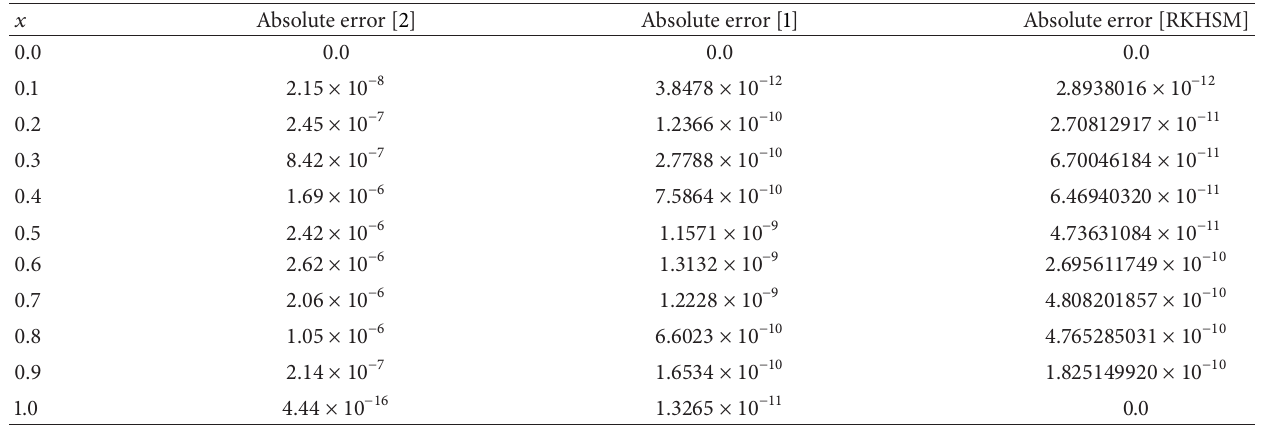
Table 2: Comparison of absolute error of HPM, VIM, and RKHSM for Example